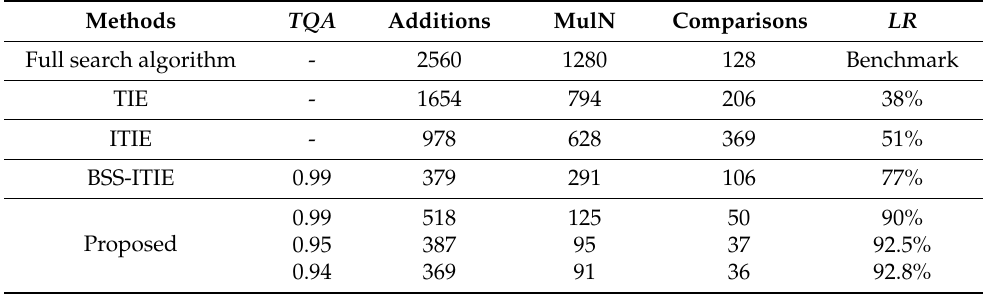
Table 5. Comparison of the basic operation numbers between the proposed method and other methods.